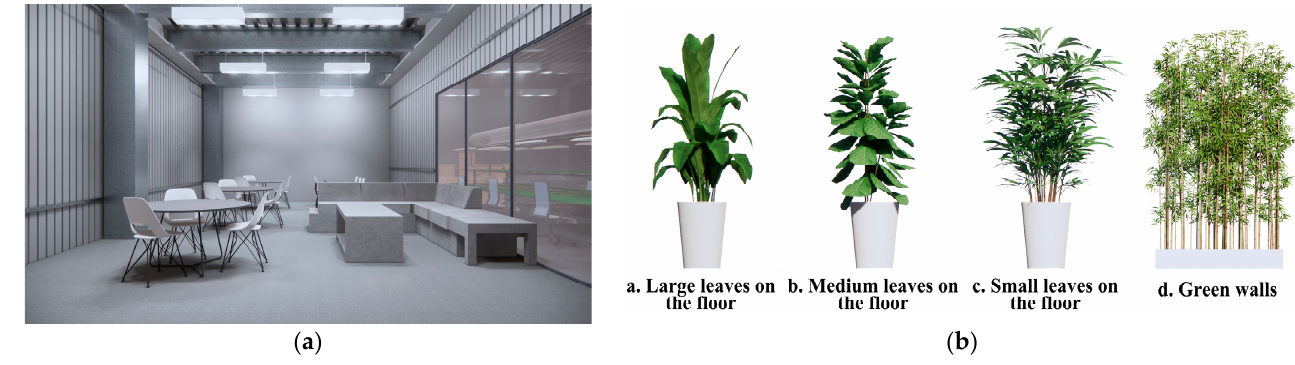
Figure 2. Implementation of the virtual space and indoor plants: ( a ) Virtual space of factory staff break areas; ( b ) Virtual four types of indoor plants.